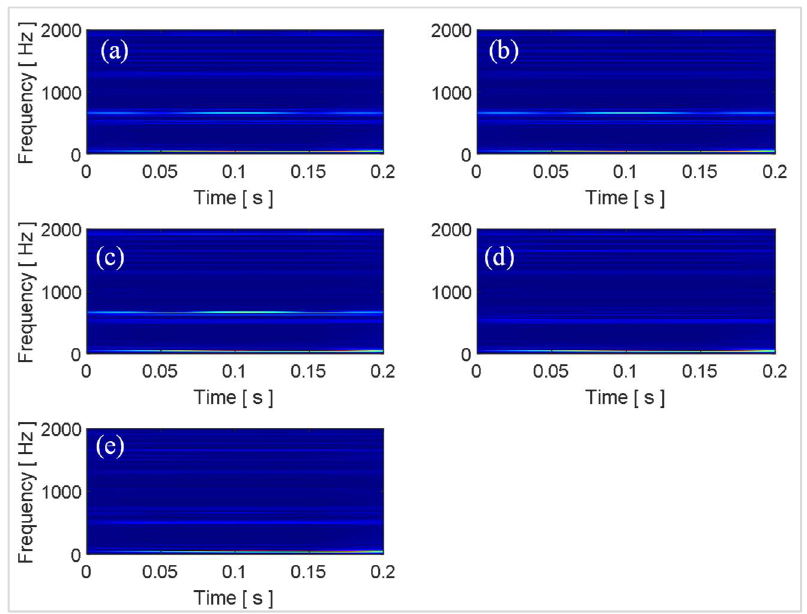
Figure 8. Some representative time-frequency images of the simulated data obtained via the SET technique: ( a ) H; ( b ) L1; ( c ) L2; ( d ) L3; ( e ) L4. technique: ( a ) H; ( b ) L1; ( c ) L2; ( d ) L3; ( e ) L4.